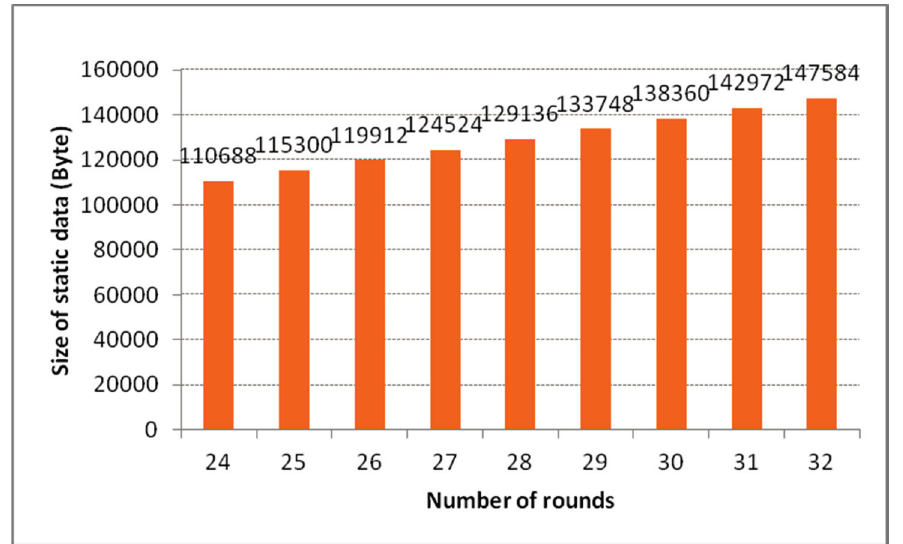
Figure 5. The size of static